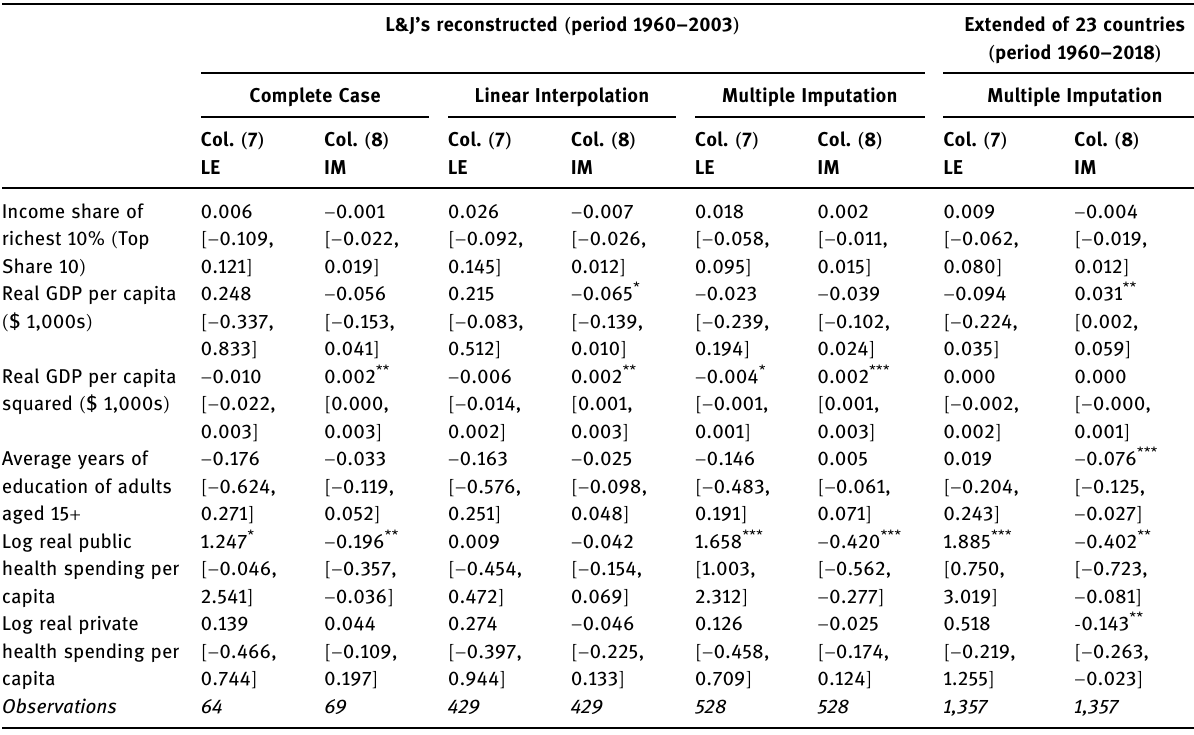
Table 4: Reproduction of two - way fi xed - e ff ect estimates using multiple